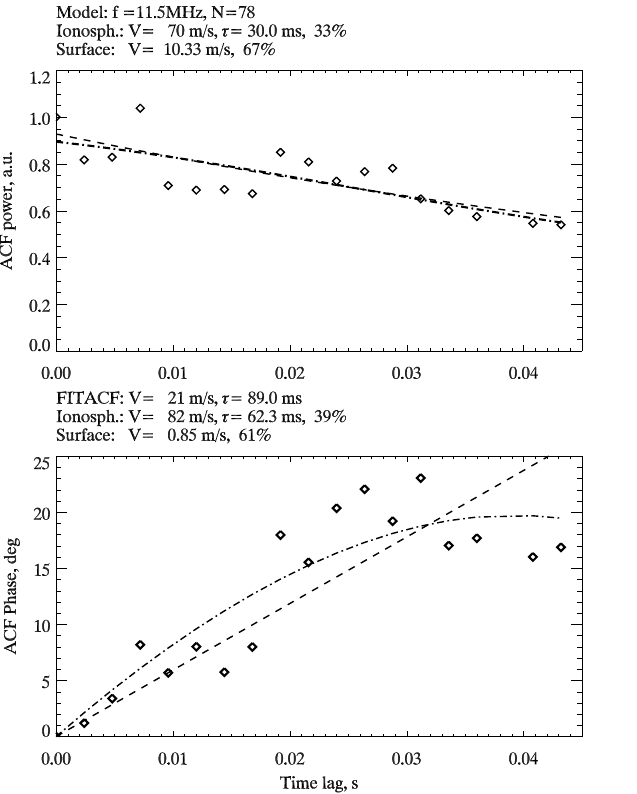
Fig. 4. Simulated example of a “bad” model ACF covering ’ 1 the interference period presented in the same format as Fig. 3.